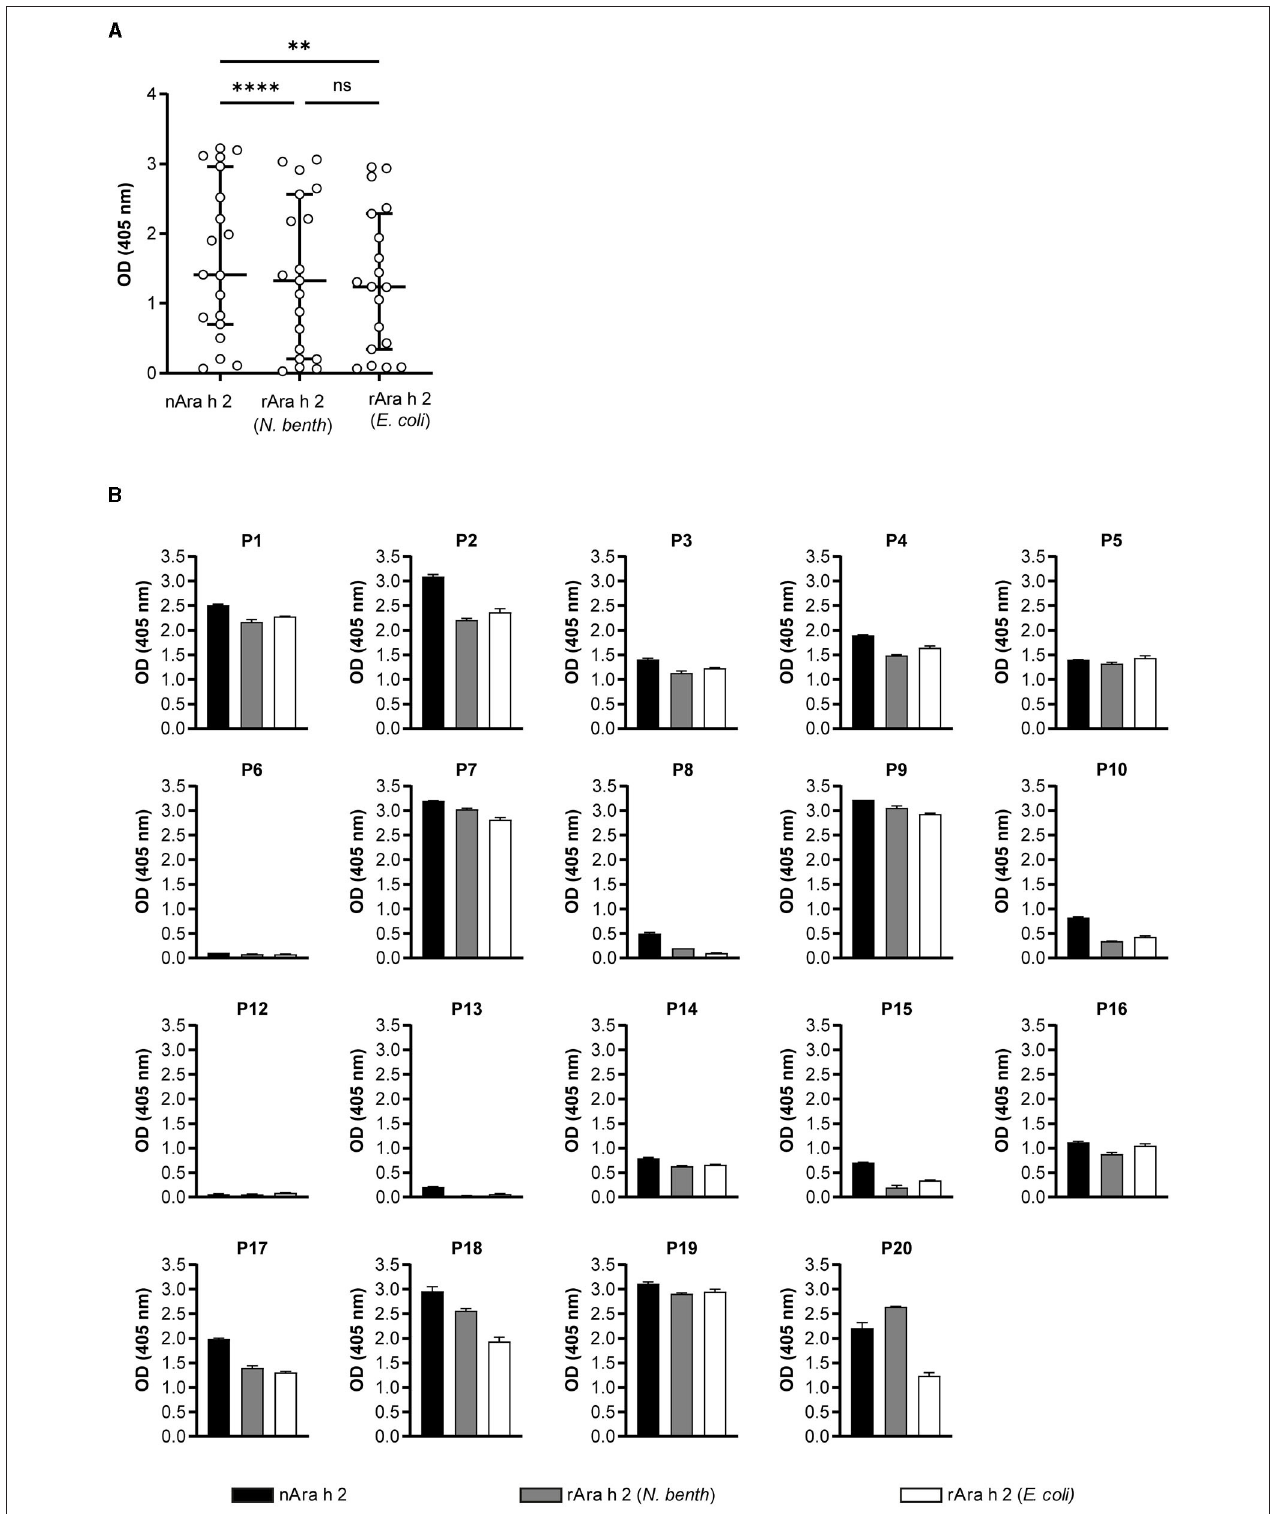
FIGURE 4 | IgE-binding of Ara h 2 proteins compared by ELISA. (A) IgE-binding to rAra h 2 from N. benthamiana was measured and compared with the nAra h 2 and the rAra h 2 from E. coli , using sera from 19 peanut-allergic patients. Data are the means of technical duplicates ( n = 2). **** P ≤ 0.0001, ** P ≤ 0.01, ns: P > 0.05. (B) IgE-binding to all three Ara h 2 proteins was determined for each patient. Error bars represent the standard deviation from technical duplicates ( n = 2).